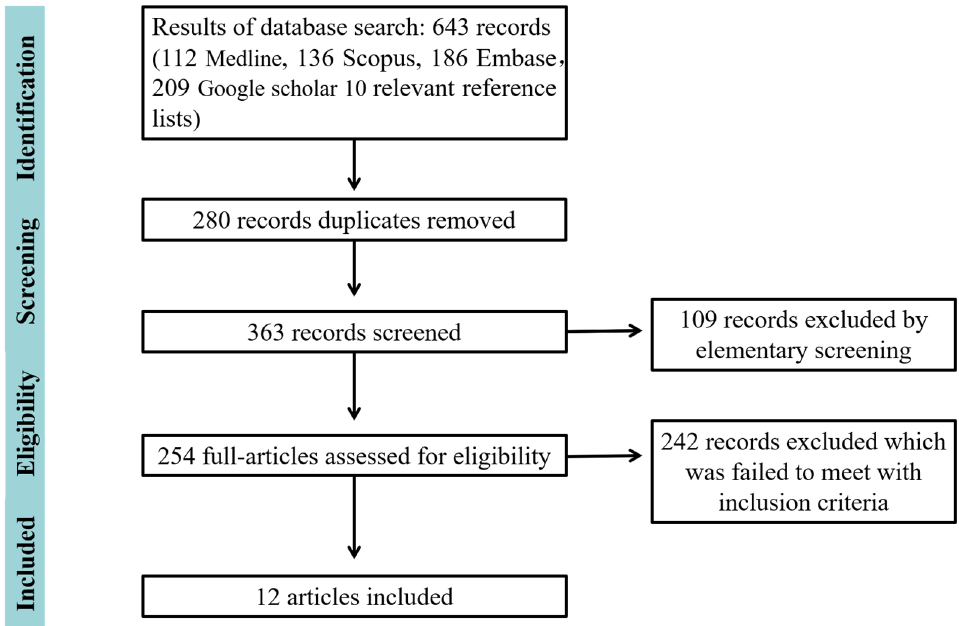
Figure 1. the screening process of included studies. Figure 1. The screening process of included